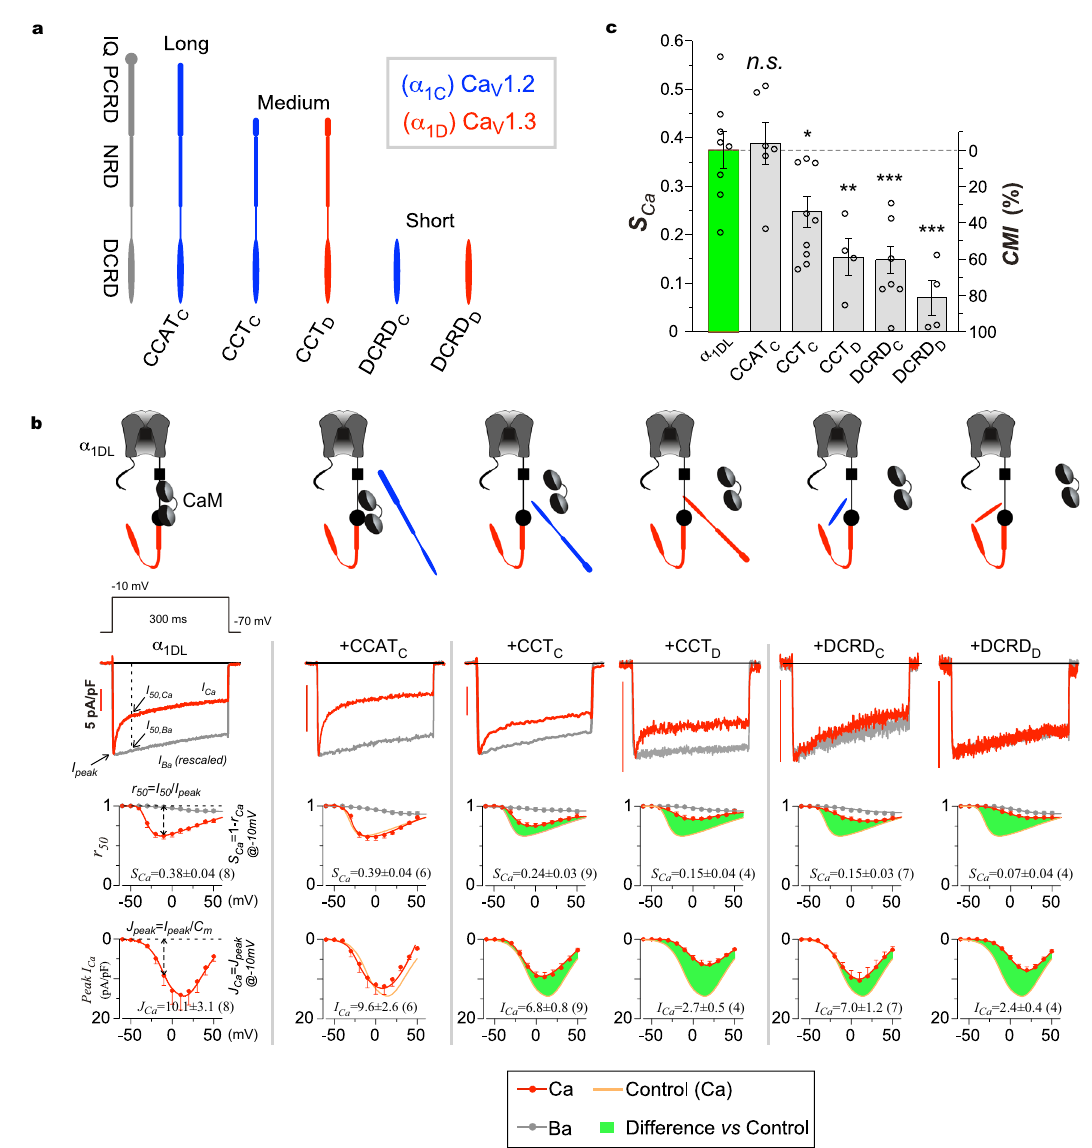
Fig. 2 Inhibition of recombinant Ca V 1.3 channels by representative DCT peptides. a Illustration of serial representative peptides encoded from DCT domains of Ca V 1.2 (blue) and Ca V 1.3 (red). The long-form peptides (~60 kDa) represented by CCAT C contain the complete set of motifs including PCRD, NRD and DCRD. The medium-form (~40 kDa) representatives CCT C and CCT D start from the very end of the PCRD till the end of the DCRD thus containing both the NRD and the DCRD. The short-form peptides (~15 kDa) are represented here by the peptides DCRD C and DCRD D . b CMI effects of representative variants on Ca V 1.3 ( α 1DL ) in HEK293 cells. As illustrated by the control group (left column), exemplary Ca 2 + current (trace with scale bar, red) and Ba 2 + current (rescaled to Ca 2 + current at the peaks, gray) were elicited by voltage step at − 10 mV (top traces). The next two rows show the pro fi les of inactivation and activation respectively, with r 50 (ration between current amplitudes at 50 ms and the peak) for inactivation and I peak (Ca 2 + current) for activation across the full range of membrane potentials ( V ). Based on Ca 2 + currents at − 10 mV, S Ca (in fraction, 1- r 50 ) and I Ca (in pA/pF, I peak ) serve as the major indices for inactivation and activation, respectively. Five representative peptides of CCAT C , CCT C , CCT D , DCRD C and DCRD D (from left to right) as in ( a ) are compared with α 1DL control (the leftmost column) for their inactivation and activation pro fi les (lines in orange indicate the control). Green areas are to highlight peptide effects. c Statistical summary of the extent of Ca 2 + -dependent inactivation ( S Ca ) and peptide ’ s CMI potency ( CMI in percentage). To evaluate the attenuation of DCT peptide on inactivation ( S Ca ), CMI potency is de fi ned as the change in Ca 2 + -dependent inactivation ( S Ca ): ( S Ca,Control − S Ca,Peptide )/ S Ca,Control , which is equivalent to fractional change in apoCaM-bound channels ( Δ F CaM ) before ( F CaM ) and after DCT peptide ’ s competition. Thus, CMI essentially indicates what percentage of apoCaM-bound channels are converted to peptide-bound channels ( f Peptide ). See Eqs. E2 and E3 in Methods for more details. One-way ANOVA followed by Dunnett for post hoc tests were used for ( c ): * p < 0.05; ** p < 0.01; *** p < 0.001. Values are represented as mean ± further insights into the mechanisms underlying DCT effects, we fi rstly focused on CCAT C , unexpectedly exerting rather mild inhibition on Ca V 1.3 channels and cortical neurons (Fig. 3g). In contrast to CCAT C , the shorter peptides of DCRD C and CCT C both encoded by Ca